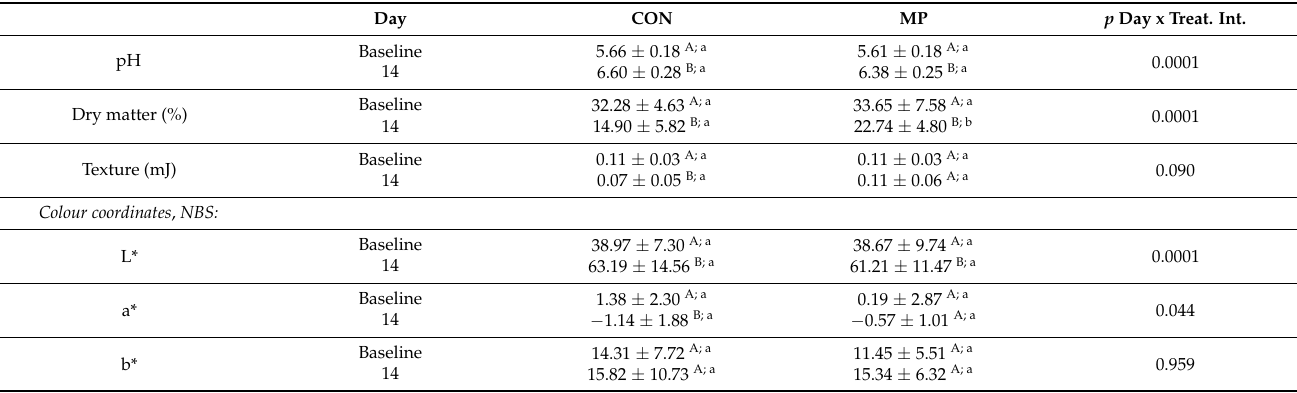
Table 3. The pH, dry matter, and colour coordinates of faeces in the calf group fed with milk replacer only (CON group) or supplemented with fermented milk permeate (MP group).